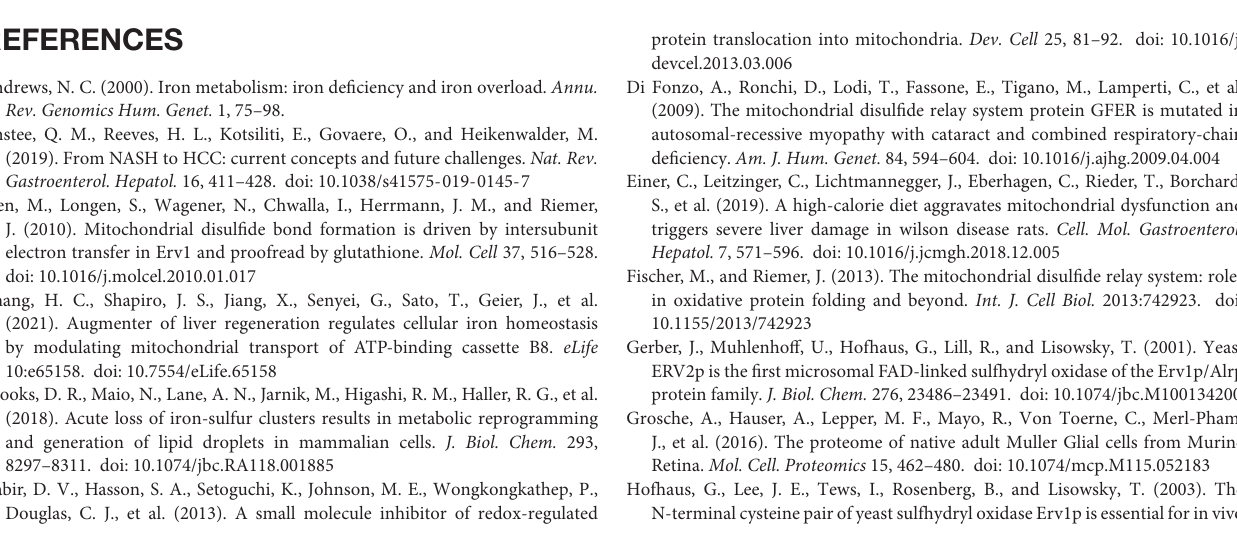
Supplementary Figure 1 | Proteomic comparison of known DRS substrates. Out of 36 quantified DRS substrates, five were significantly upregulated by at least 1.5-fold, one was significantly downregulated by at least 0.5-fold and 30 proteins remained unchanged in expression levels upon MB-6 treatment. Supplementary Figure 2 | Other mitochondrial redox pairs are not affected by ALR inhibition. Deferoxamin as a further iron chelator acts similar to TS-22. (A) MB-6 treatment did neither change cellular NAD + /NADH ratios nor NADPH/NADP + ratios. (B) Deferoxamin treatment shows clear co-toxicity together with MB-6 treatment. Supplementary Figure 3 | Methemalbumin decreases the SubG1 cell population in MB-6 treated cells. Supplementation with methemalbumin alone does not change cell cycle but distinctively reduces the SubG1 population from MB-6 treatment. Supplementary Figure 4 | Methemalbumin increases cellular and mitochondrial iron levels but does not restore GSH/GSSG levels. Copper levels are unaffected by MB-6 treatment. (A) Cellular and mitochondrial iron uptake by methemalbumin addition are comparable in both methemalbumin and double treated